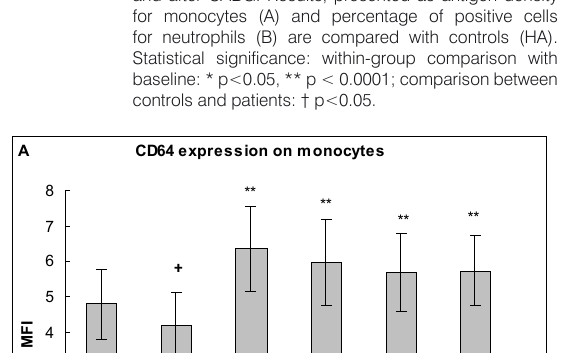
Figure 2. CD32 expression on peripheral blood monocytes before and after CABG. Results are compared with